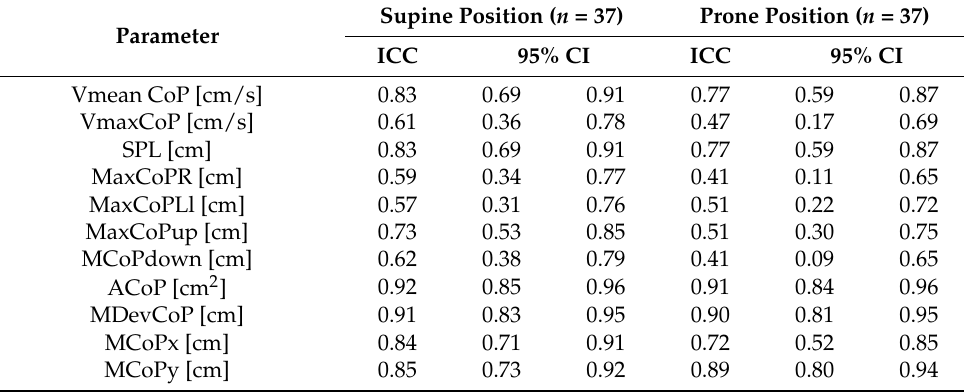
Table 5. Intraclass correlation coefficients for the first and second measurements of individual parameters describing the spontaneous sway of CoP and the area of CoP in the whole group of infants, i.e., those who presented with normal and abnormal FMs patterns in PT in supine and prone positions. Supine Position ( n = 37) Prone Position ( n = 37) Parameter